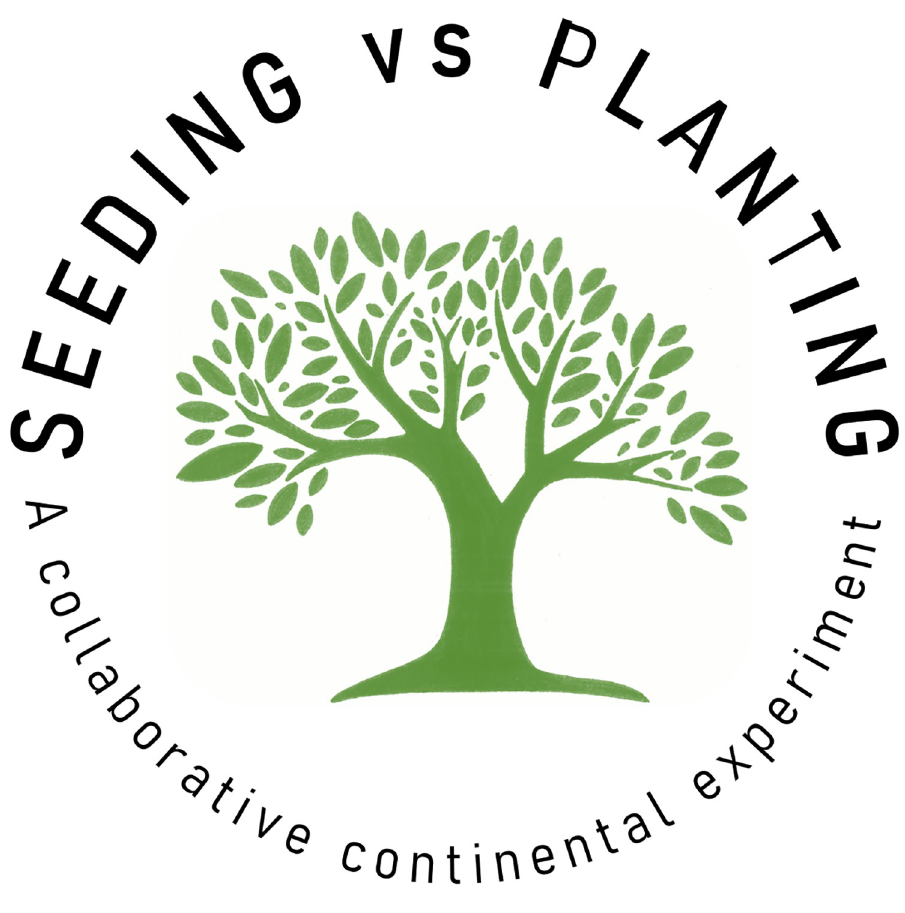
Fig 5. Logo for the